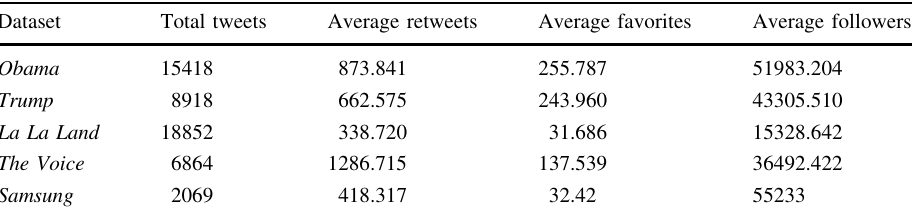
Table 1 Dataset characteristics